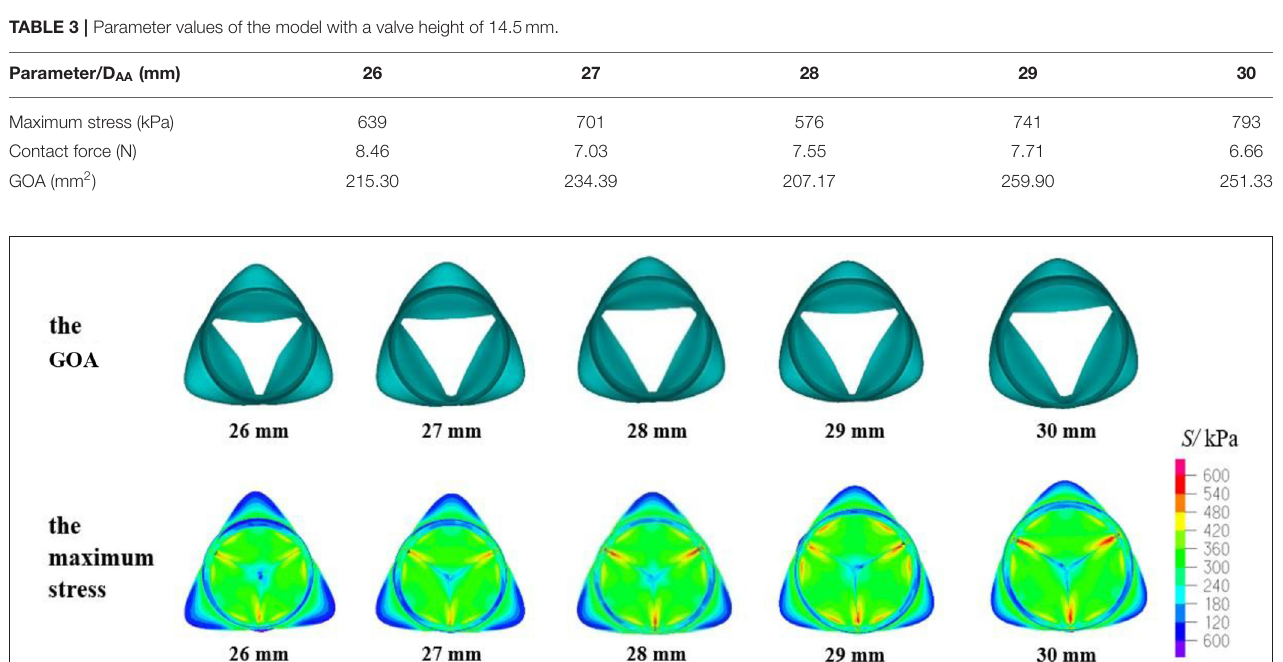
FIGURE 7 | GOA of the valve and maximum stress distribution of the model with H V = 14mm and D AA of 26–30mm.